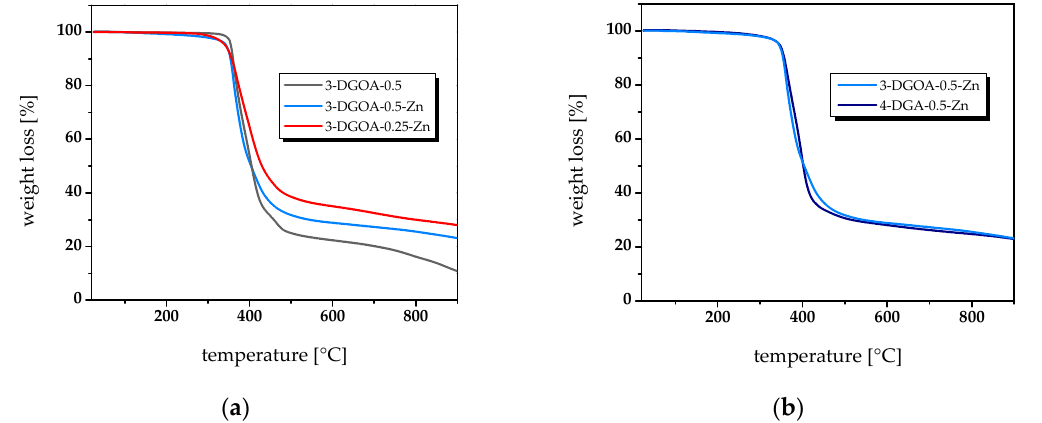
Figure 4. TGA curves of epoxy-anhydride vitrimers. ( a ) Influence of catalyst and stoichiometry on the thermal stability of vitrimers from 3-DGOA and glutaric acid and ( b ) influence of the type of epoxy monomer (3-DGOA vs. 4-DGA) on the thermal stability of catalysed vitrimers (epoxy and anhydride groups in stoichiometry).